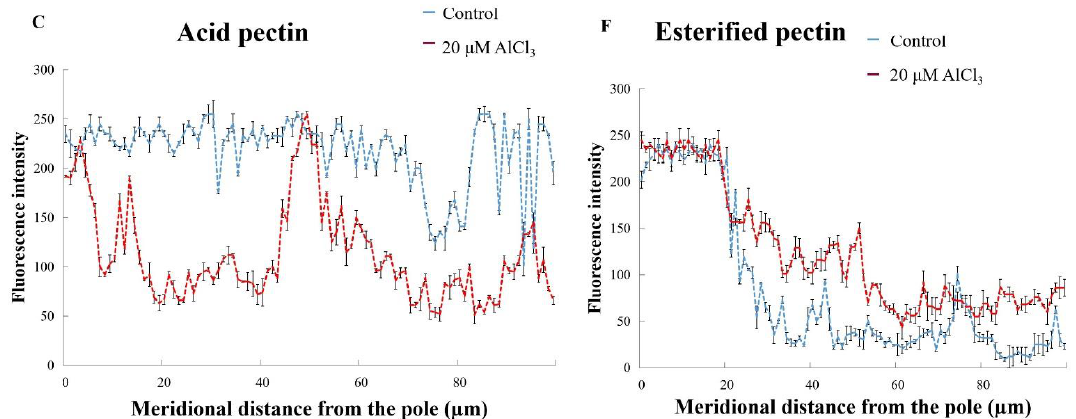
Figure 5. Effect of 20 µM AlCl 3 on pectin distribution of pollen tube wall of M. domestica. ( A ) Bright- field image of a control pollen tube. ( A1 ) Acid pectins of the control pollen tube in A labeled with JIM 5 under CLSM. ( B ) Bright-field image of a pollen tube treated with 20 µM AlCl 3. ( B1 ) Acid pectins of the pollen tube in B. ( C ) Quantitative analysis of the fluorescent intensity of acid pectins (JIM 5) in the wall of control (blue line) and 20 µM AlCl 3 (red line) pollen tubes. ( D ) Bright-field image of a control pollen tube. ( D1 ) Esterified pectins of the pollen tube in D labeled with JIM 7 under CLSM. (E) Bright-field image of a pollen tube treated with 20 µM AlCl 3. ( E1 ) Esterified pectins of the pollen tube in E. ( F ) Quantitative analysis of the fluorescent intensity of esterified pectins of control (blue line) and 20 µM AlCl 3 treated (red line) pollen tubes. Bar = 10 µm. LM6 could label (1 → 5)- α -L-arabinan, a structural feature of the side chains of pectins [22]. To specify how much pectin epitopes are involved in pollen tube growth, the antibody (LM 6) was used to label arabinan pectins. Arabinan pectins was distributed on both the control and the 20- µ M-AlCl 3 -treated pollen tube walls. At the tip of the pollen tube, stronger fluorescence was observed on the 20- µ M-AlCl 3 -treated pollen tube (Figure 6B1). Thus, 20 µ M AlCl 3 increased arabinan pectins in pollen tubes.